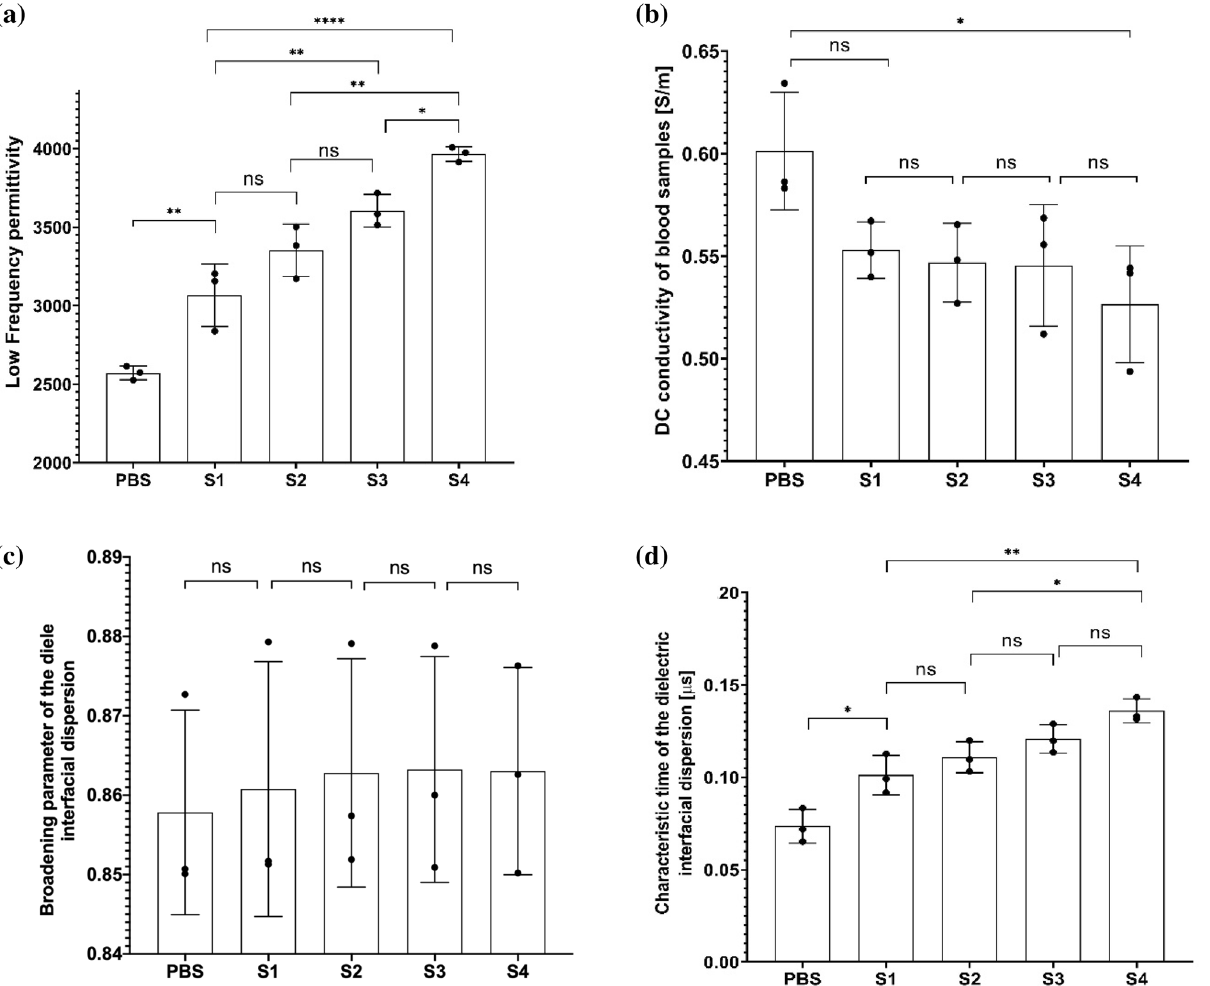
Figure 4. Comparison of low frequency permittivity ( ε l ) ( a ), conductivity ( σ DC ) ( b ), dispersion broadening parameter ( a ) ( c ), and dielectric relaxation time constant ( τ ) ( d ) of the experimental data from measurements with blood samples of varying HES concentration. The displayed data is for time point t = 100 s . Results are shown using box plots. One-way ANOVA with Tukey’s post-hoc test is used for multiple comparison. Probability values are indicated on figures by asterisks, as follows: *p < 0.05; **p < 0.01, ***p < 0.001, ****p <